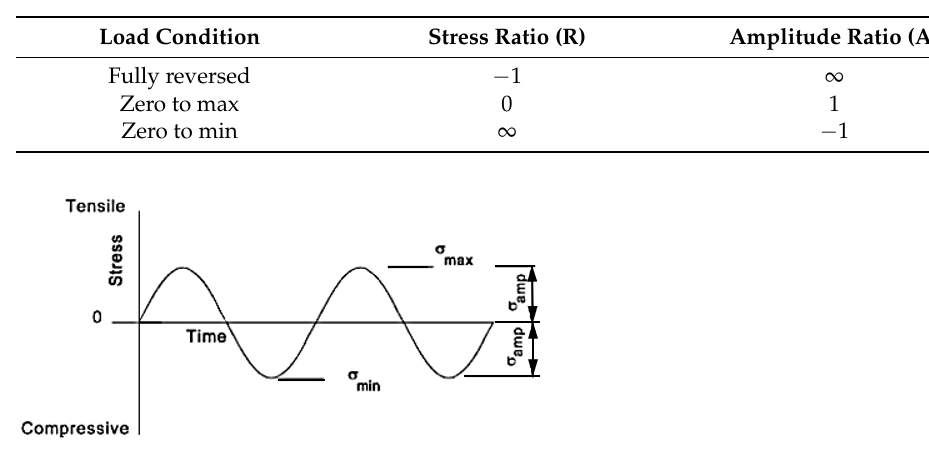
Figure 22. Tensile cyclic load. The general characteristics of the effect of average stress are graphed in Figure 23, and representative relational expressions showing the effect of average stress are written in (7)–(9). Figure 23 shows the fatigue limit (Se), yield strength (Sy), and ultimate tensile strength (Su). Goodman’s theory of Equation (7) can obtain stable results for low ductility metals, and Soderberg’s theory of Equation (8) is more conservative than Goodman’s and is mainly used for brittle materials. The parabolic Gerber theory of Equation (9) is suitable for ductile materials in the state of tensile mean stress [31–33]. In this study, fatigue analysis was performed by applying Goodman’s theory to ob- tain results for ductile metal, and the amplitude ratio A = −1 was used because the load of the extruder stem is applied in the compression direction.